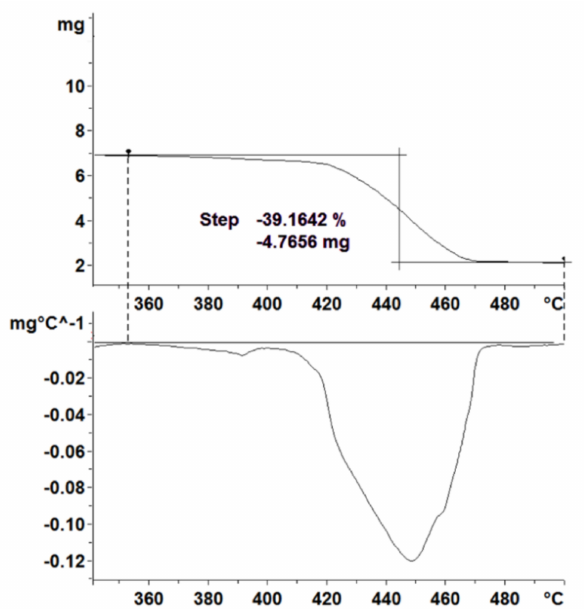
Figure 4. Calculation of the mass loss as relative change in mass of an event in a TGA curve. The beginning and end of a thermal event are determined using the first derivative curve (DTG) curve as shown in the lower graph.